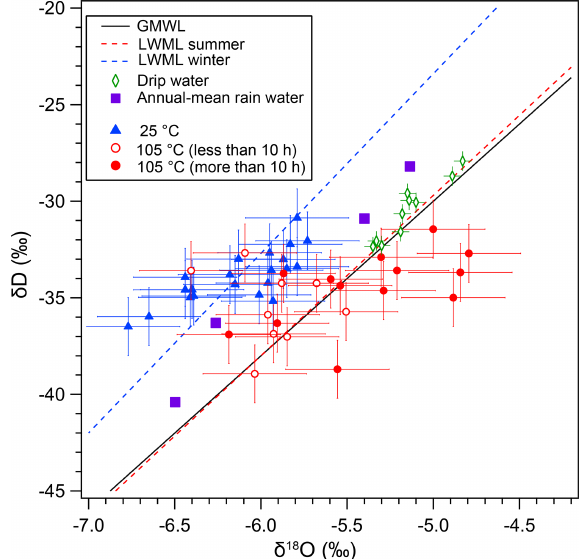
Figure 4. D–O plot of inclusion water. Blue triangles indicate the isotopic compositions of the fluid inclusion in the 25 ◦ C drying ex- periment. Red circles indicate the isotopic compositions of the fluid inclusion in the 105 ◦ C drying experiment for <10h (open red cir- cles) and >10h (solid red circles). The black line indicates GMWL. Local meteoric water lines based on present-day rain data from Ok- inawa Island for the summer season (red dotted line) and the winter season (blue dotted line) are also shown. Purple solid squares in- dicate precipitation-weighted annual mean values (2009–2012) of the rainwater on Okinawa Island. Green open diamonds indicate present-day observation of drip water in Hoshino